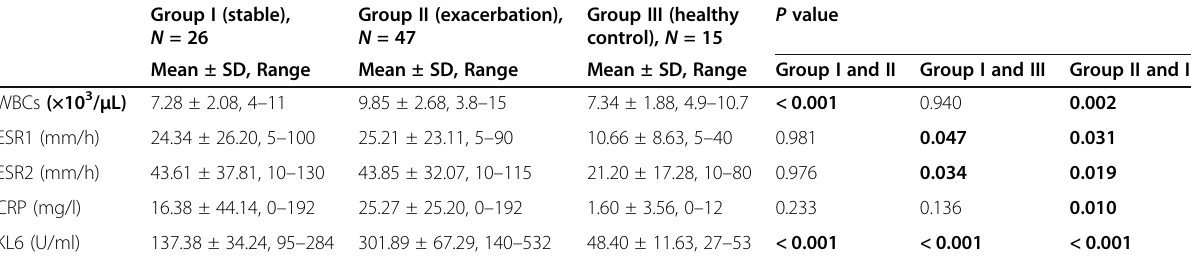
Table 5 Laboratory findings of studied groups Group I (stable), N = 26